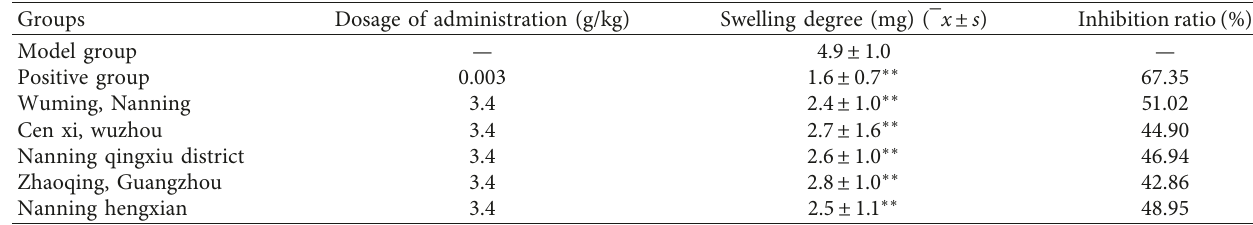
Table 2: Experimental results of ear swelling induced by dimethylbenzene in mice ( n � 8). Groups